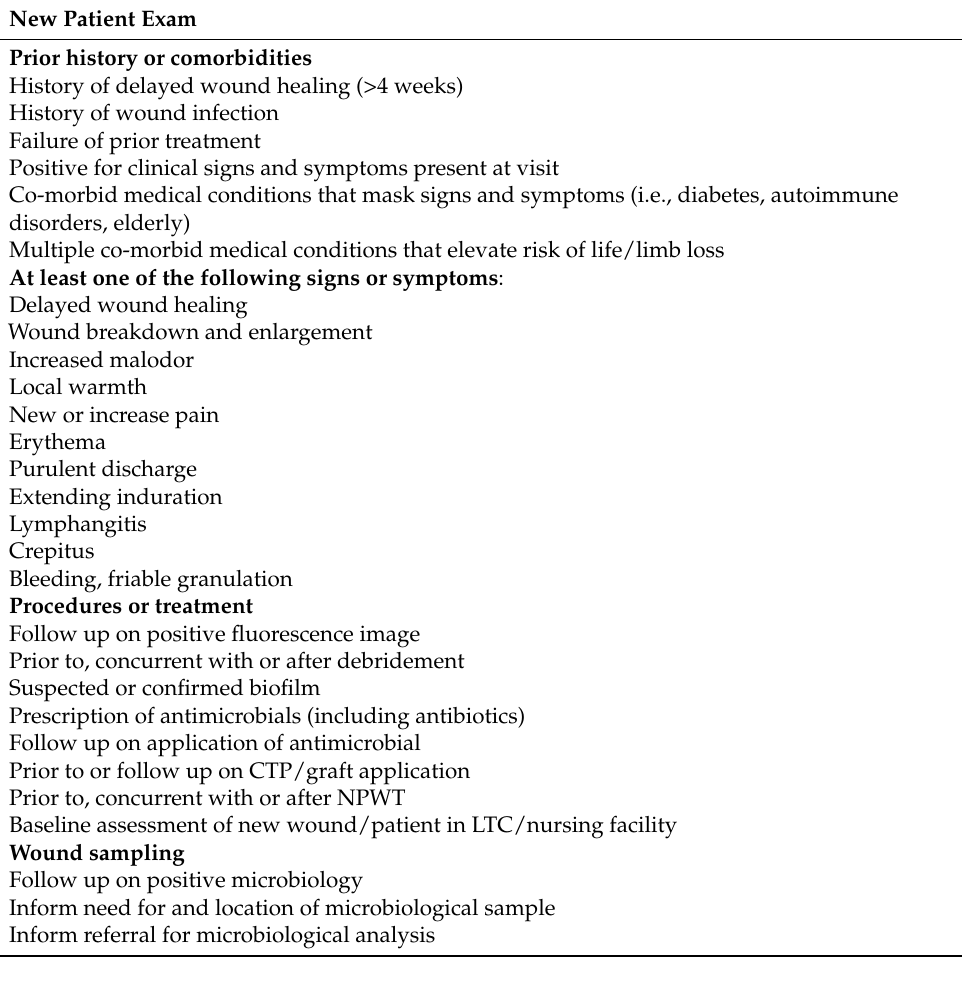
Table 4. Recommended use of fluorescence imaging for detection of bacterial